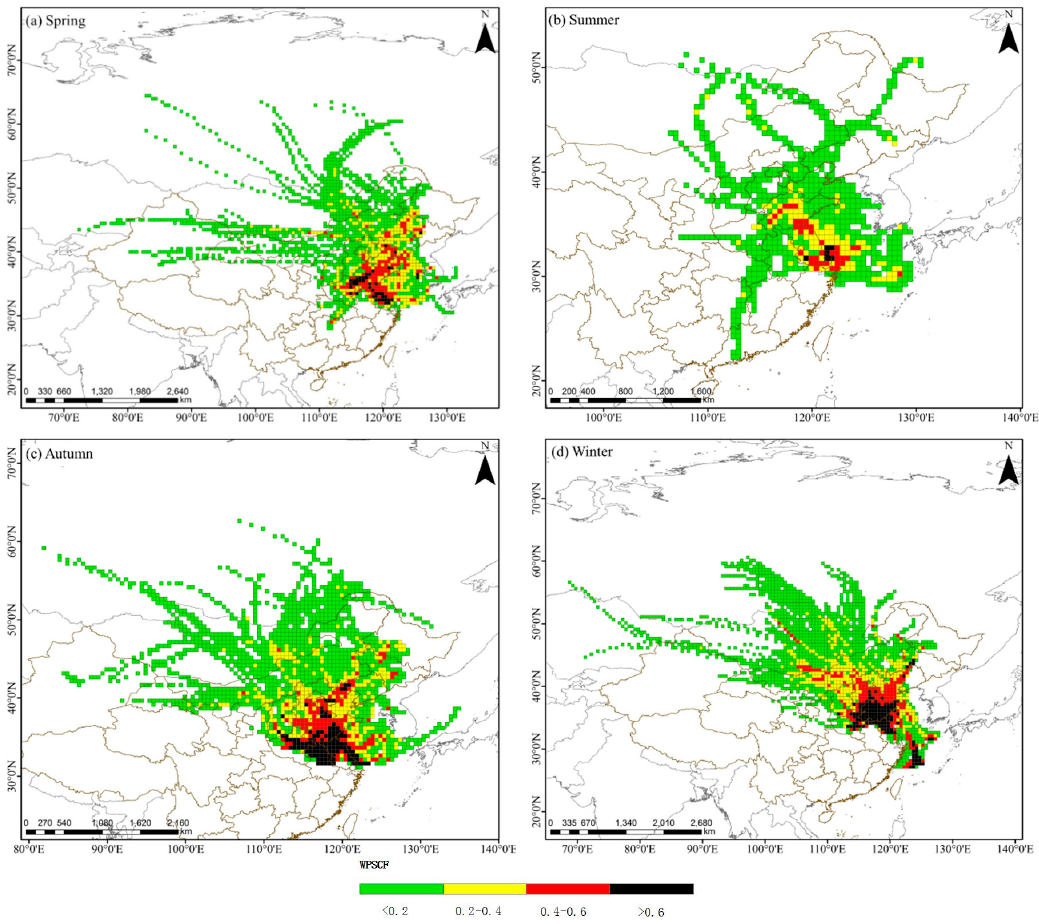
Figure 5. Spatial distribution of WPSCF values of PM 2.5 in spring, summer, autumn, and winter from March 2015 to February 2016.